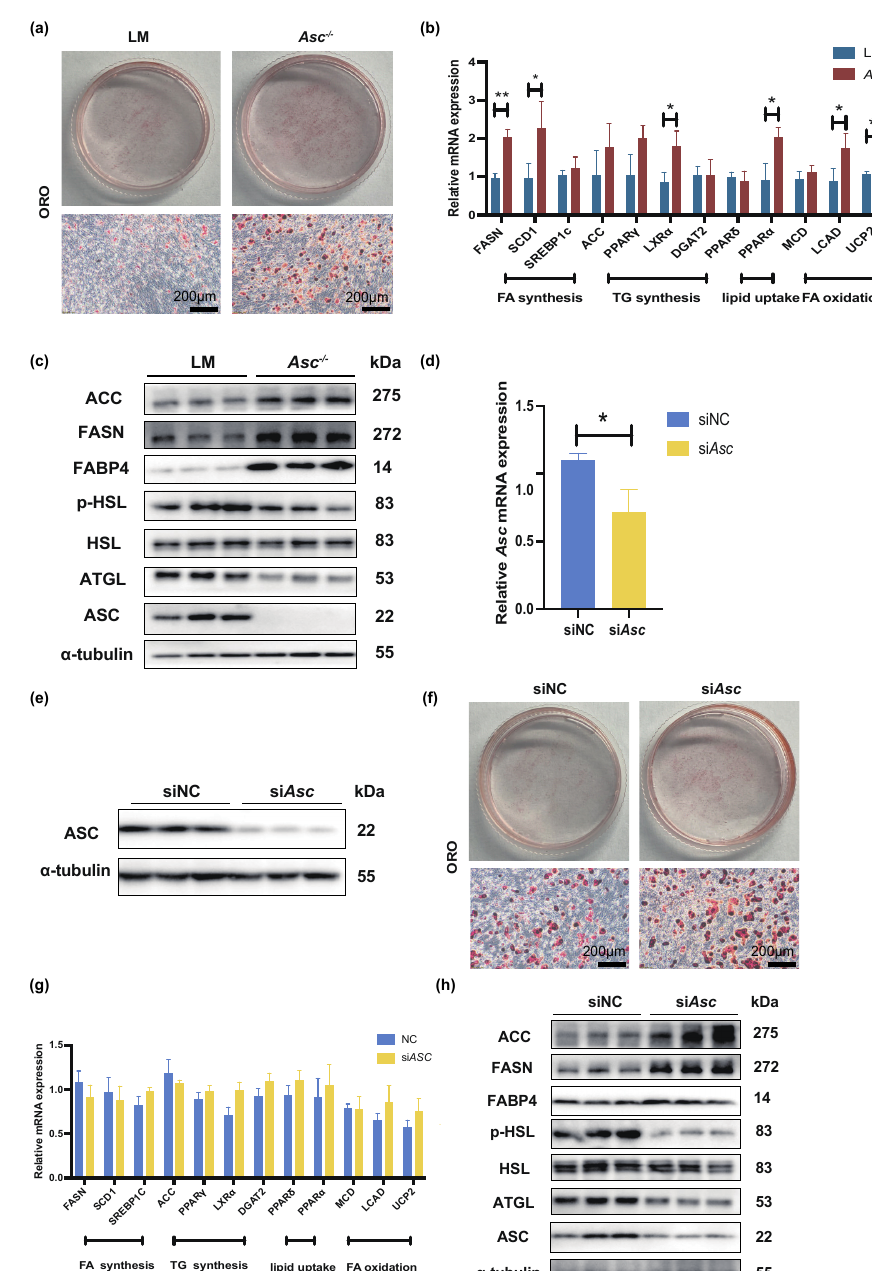
Figure 3. Ablation of ASC in stromal vascular fractions (SVF) cells improved the lipogenesis but impaired lipolysis. ( a – d ) Primary SAT SVF cells of LM and Asc − / − mice (Red-LM mice, Blue- Asc − / − mice). ( a ) Oil Red O staining of the 6th day under lipogenesis inducement treated primary SAT SVF cells, separated from LM and Asc − / − mice, scale bar 200 µ m. ( b ) The expression of lipogenesis genes was analyzed by RT-qPCR. ( c ) Expression of lipogenesis (ACC, FASN, FABP4) and lipolysis (p-HSL, HSL, ATGL) protein in indicated cells. ( d – h ) Primary SAT SVF cells separated from WT mice were transfected with siRNA targeting for ASC on the 4th day (Blue-NC, Yellow-si Asc ). ( d , e ) mRNA and protein level of ASC in indicated cells. ( f ) Oil Red O staining of the 6th day under lipogenesis inducement treated in indicated cells, scale bar 200 µ m. ( g ) Expression of lipogenesis genes in indicated cells. ( h ) Expression of lipogenesis (ACC, FASN, FABP4) and lipolysis (p-HSL, HSL, ATGL) protein in indicated cells. Data are presented as means ± SD from three independent experiments. * p < 0.05 and ** p <